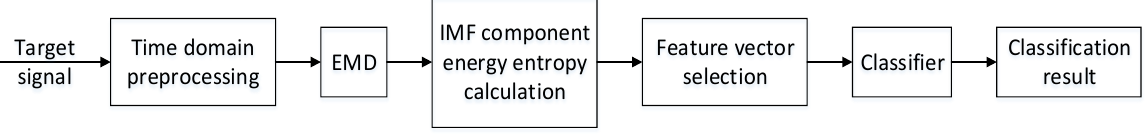
Figure 7. Recognition process of feature extractor based on IMF energy.